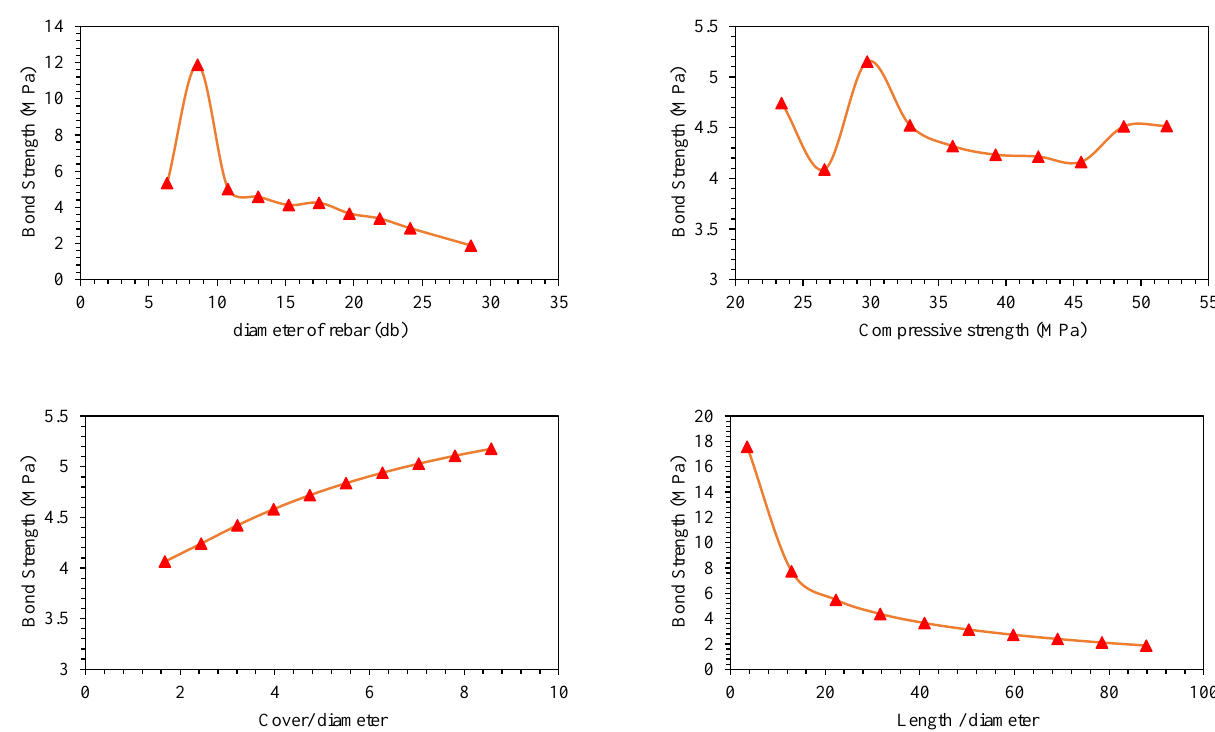
Figure 13. Effect of the contributing parameters on BS for B p type-I and B s type III.